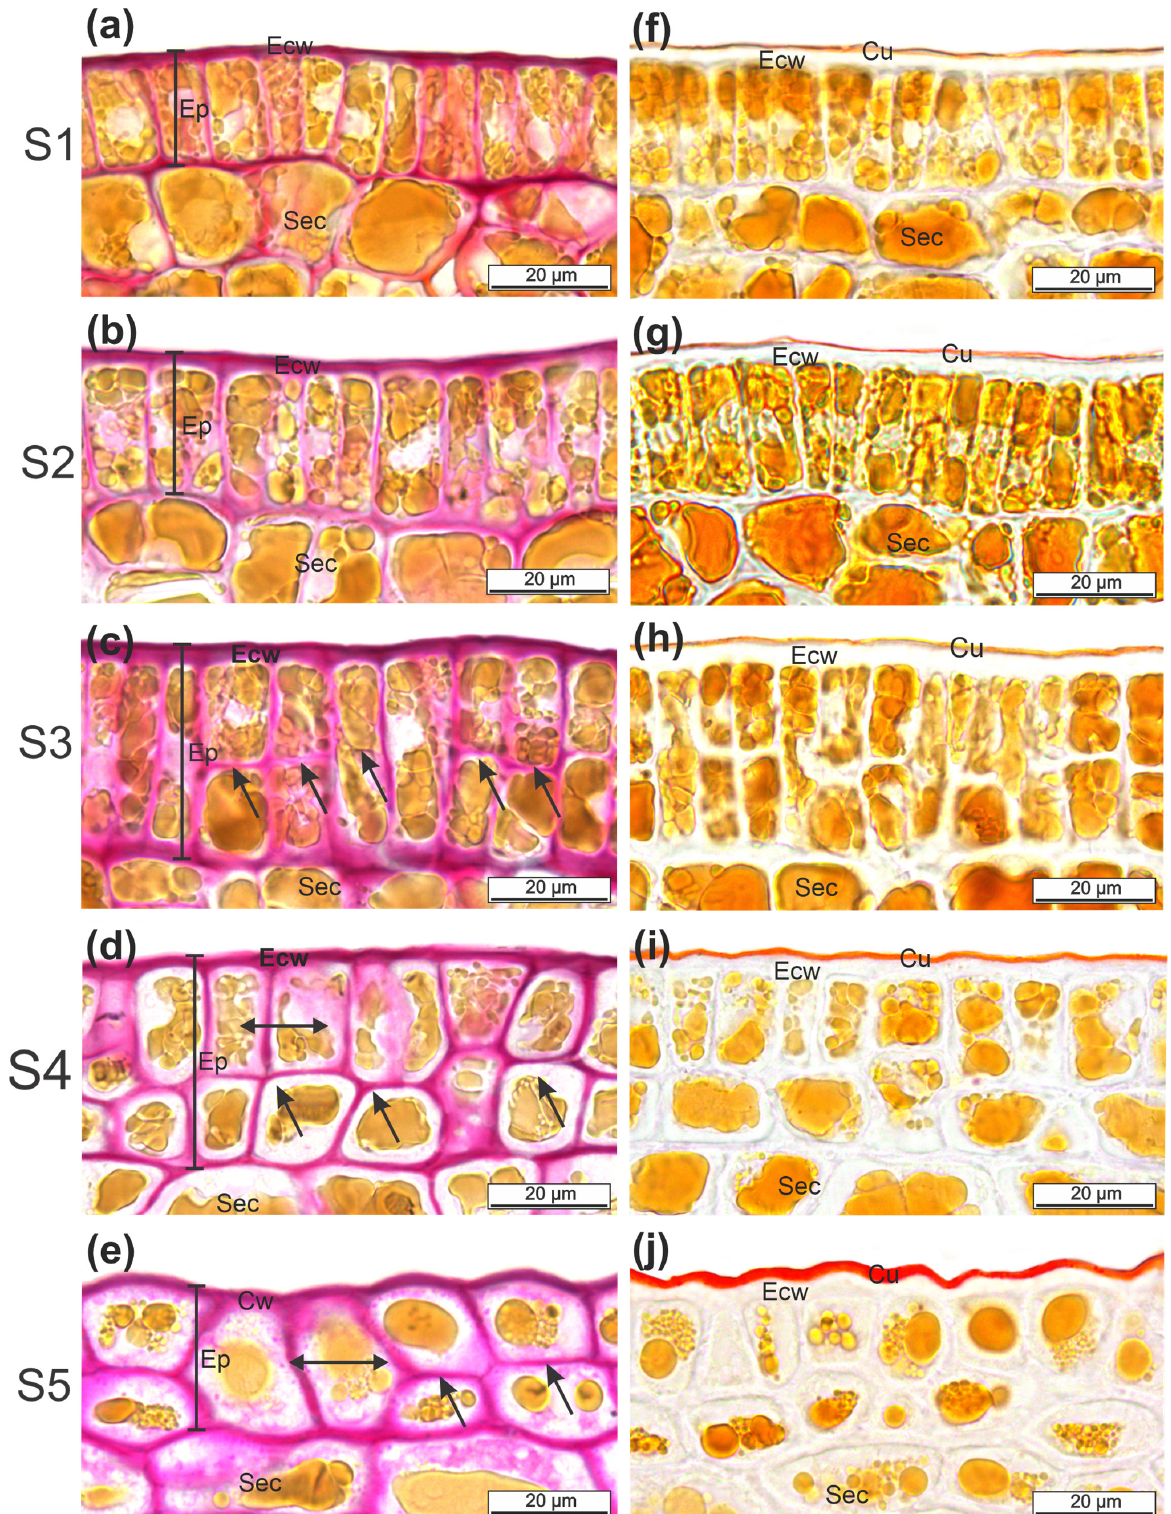
Figure 3. Photomicrographs of cross-sections of CCP 76 cashew pseudofruits in five stages (S1, S2, S3, S4, and S5). ( a – e ): Ruthenium red test for pectic substances and polysaccharides showing the cell wall. ( f – j ): Positive test for lipids with Sudan IV showing the cuticle. Cell division (black arrow). Cu = cuticle, Ecw = external cell wall, Ep = epidermis, Sec = subepidermal cell.